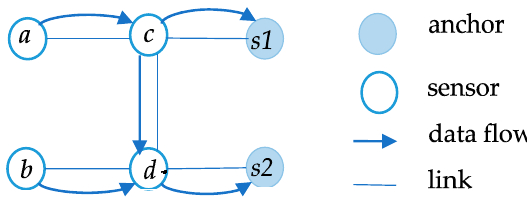
Figure 4. Data transmission model. Table 1. List of notations.